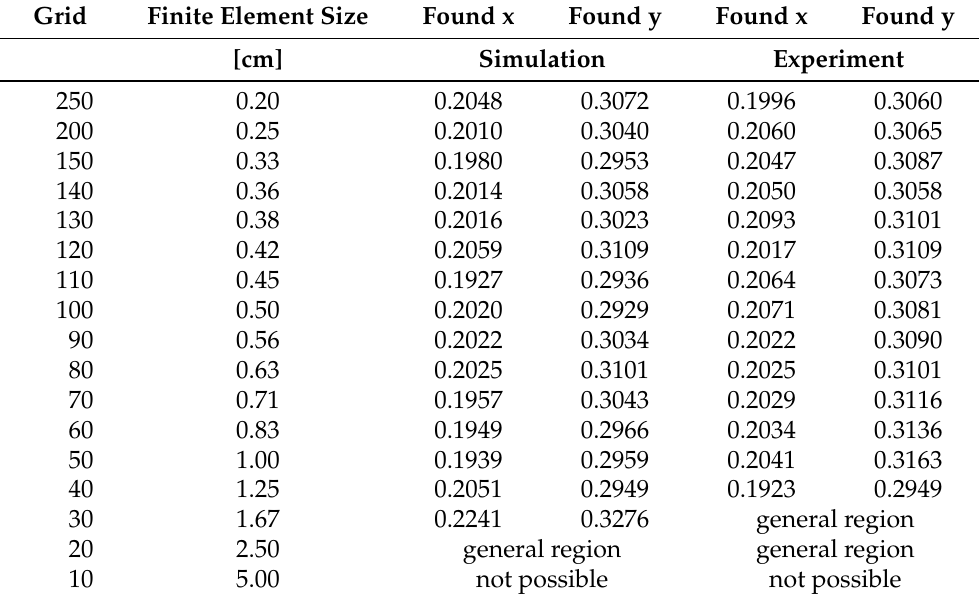
Table 1. Damage location (in cm from plate edges) identified by the use of RMS of calculated and measured